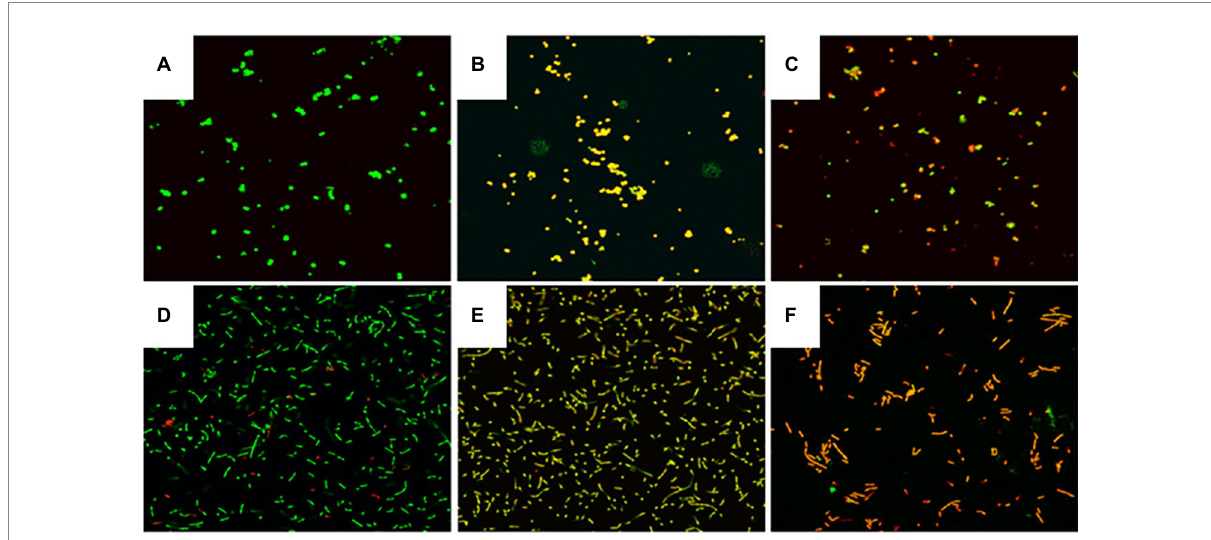
FIGURE 4 Effect of MDA on the integrity of the cell membrane of S. xylosus and L. plantarum . (A) S. xylosus untreated; (B) S. xylosus treated with MDA at MIC; (C) S. xylosus with MDA at 2MIC; (D) L. plantarum untreated; (E) L. plantarum treated with MDA at MIC; (F) L. plantarum with MDA at 2MIC.